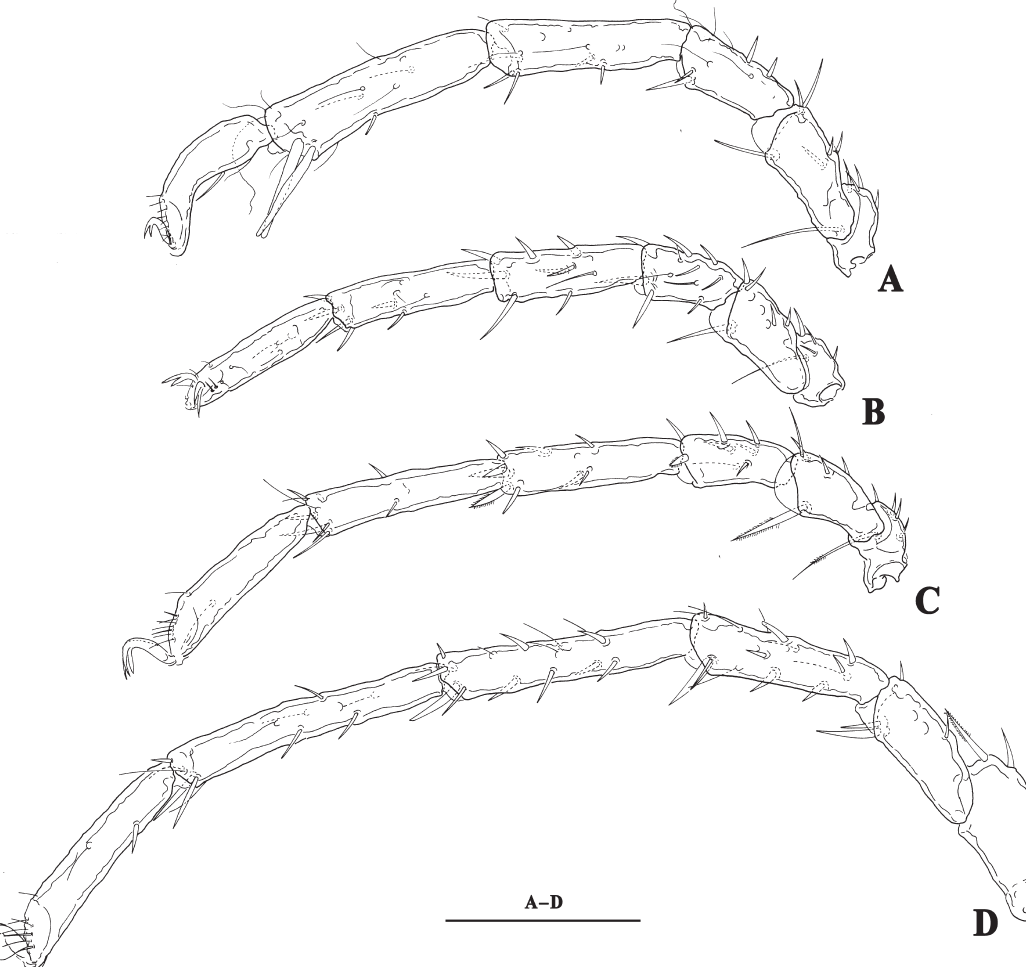
Fig. 5. Atractides ( Atractides ) smiti Zhang, Li & Guo sp. nov., holotype, ♂ ( GUGC, Slide No.